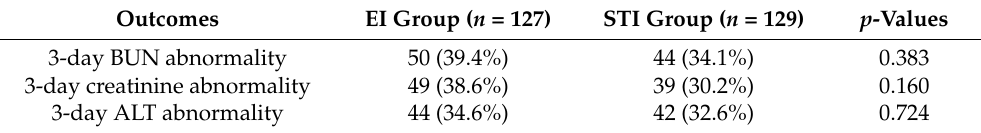
Table 4. EI of meropenem safety